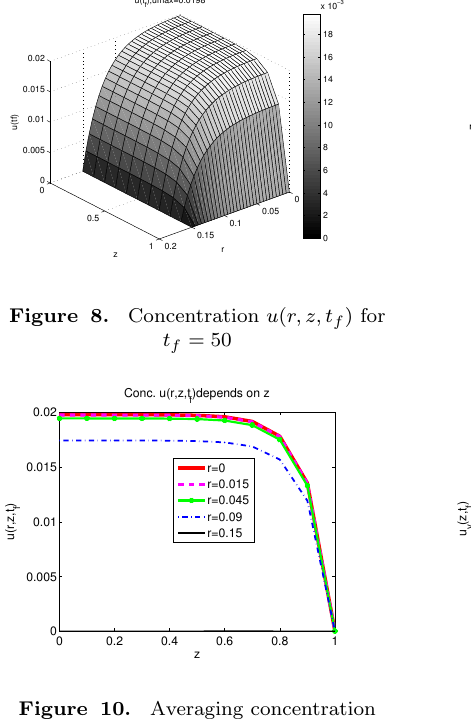
Figure 11. Averaging concentration u v ( z,t f ) depending on z for t f = 50